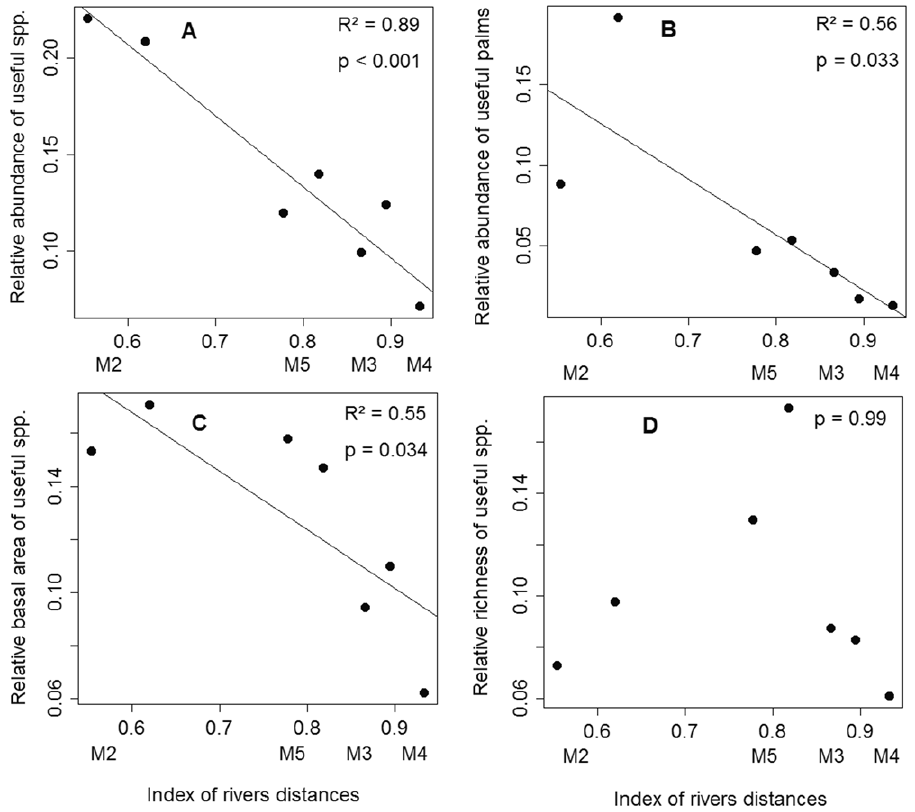
Figure 4. Relationships between useful tree parameters and the distance to secondary rivers. Relationships between the relative abundance of useful species per plot (A), the relative abundance of useful palms per plot (B), the relative basal area of useful species per plot (C) and the relative richness of useful species per plot (D), with the distances from secondary rivers. Points are the plots of sites M2, M3, M4, M5, totaling seven plots. The index of rivers distances is the sum of the inverse distances from each plot to all perennial rivers greater than 50 m wide in a 25 km diameter zone around the sites.